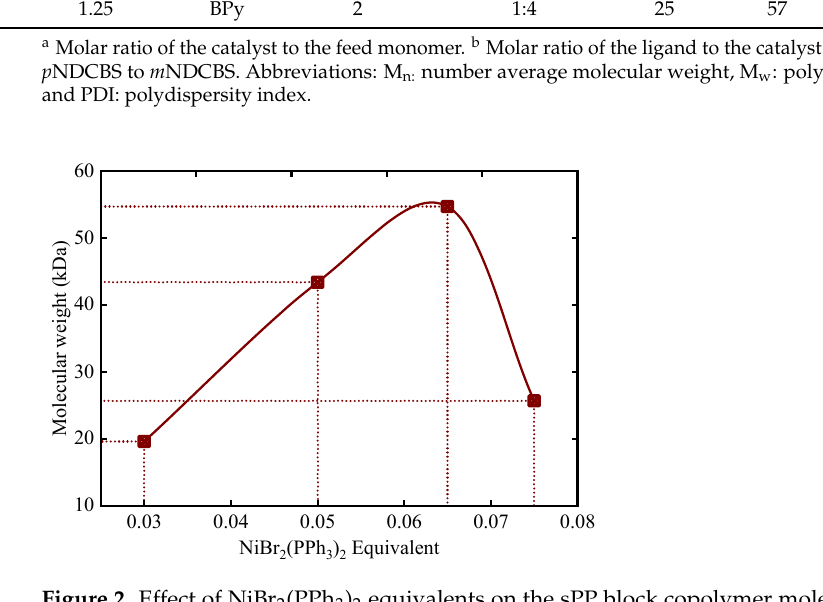
Figure 2. Effect of NiBr 2 (PPh 3 ) 2 equivalents on the sPP block copolymer molecular weight, when